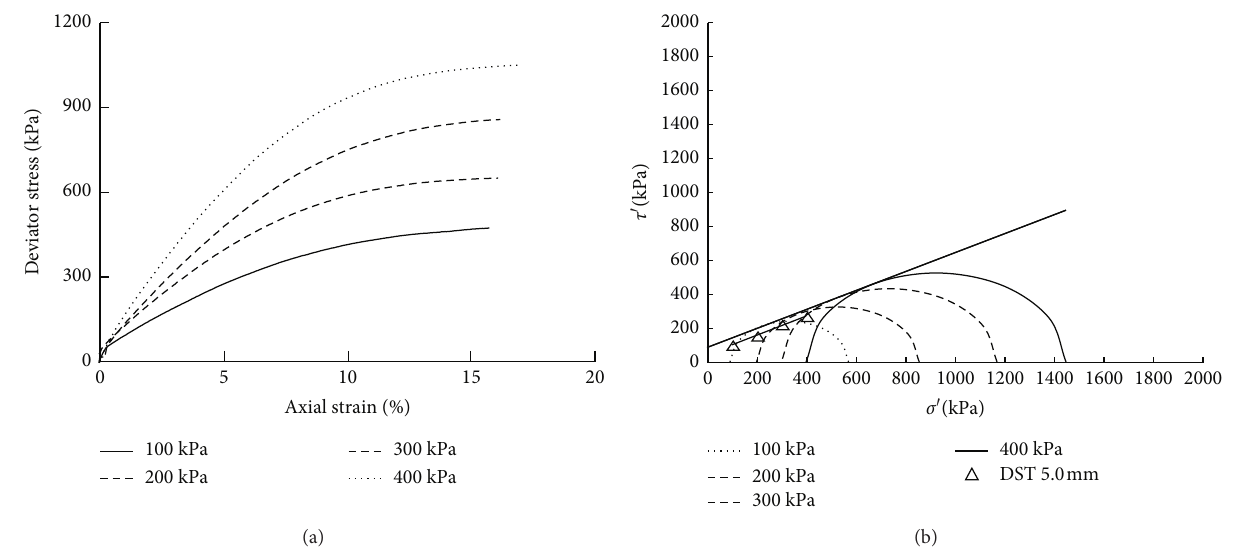
Figure 11: (a) Variation of deviatoric stress with axial strain for G1. (b) Comparison of shear strength determined by direct shear test (opening size 5.0mm) and triaxial tests for